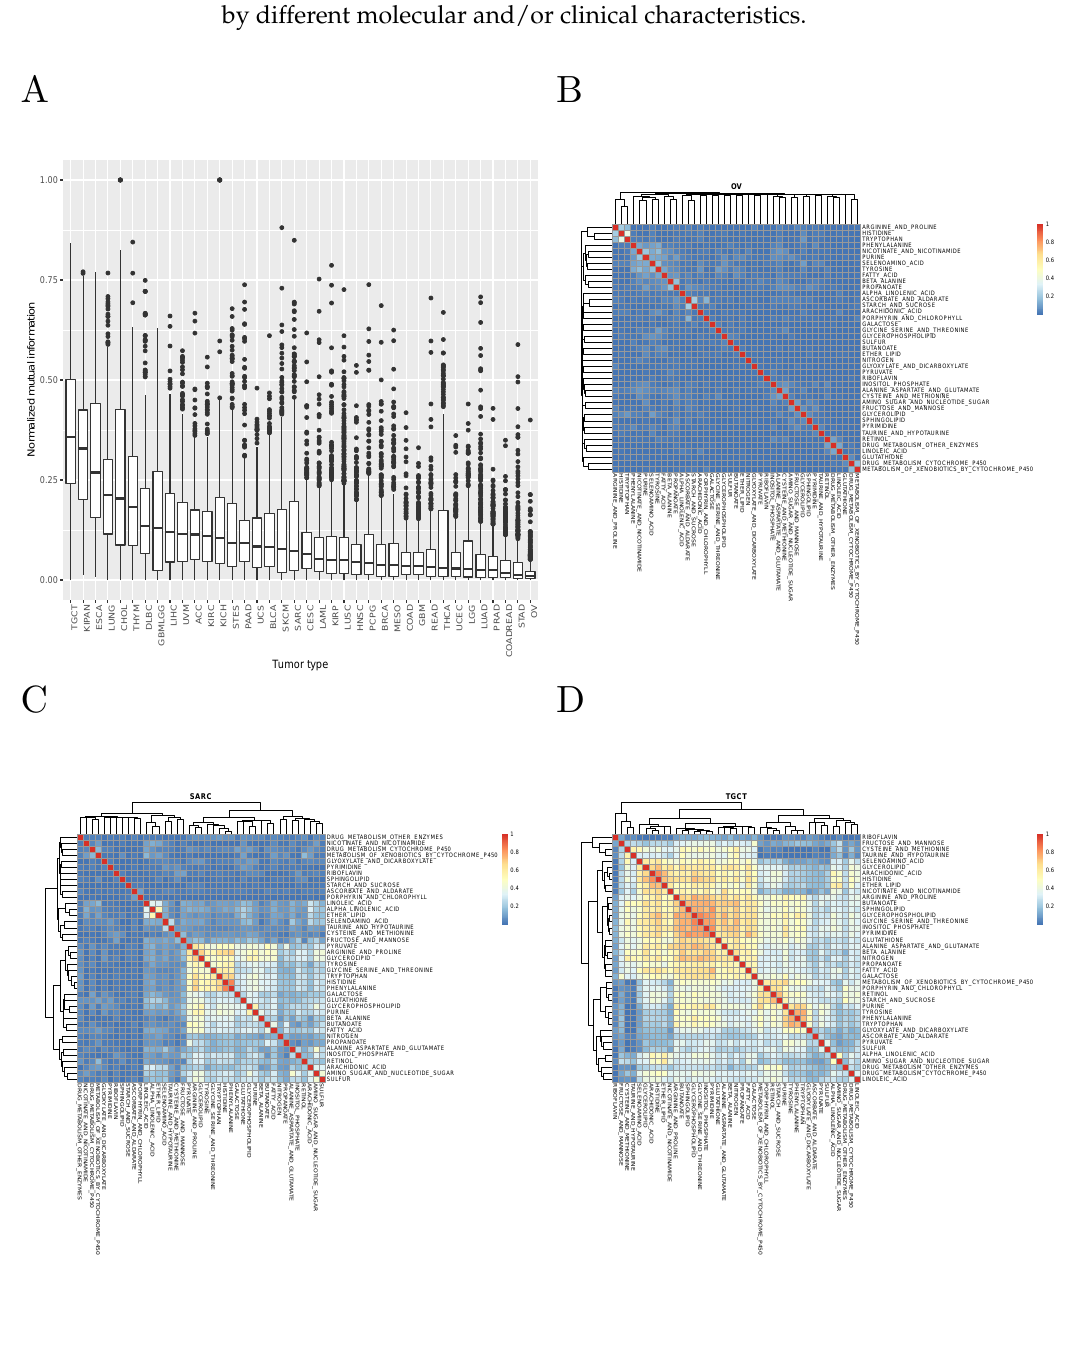
Figure 2. ( A ): Normalized mutual information between clusterings of samples using KEGG metabolic gene sets (tumor type abbreviations are those used by the TCGA and are explained in Supplementary Table S1). ( B – D ): Examples of tumor types with low, intermediate, and high normalized mutual information between clusterings obtained with different metabolic